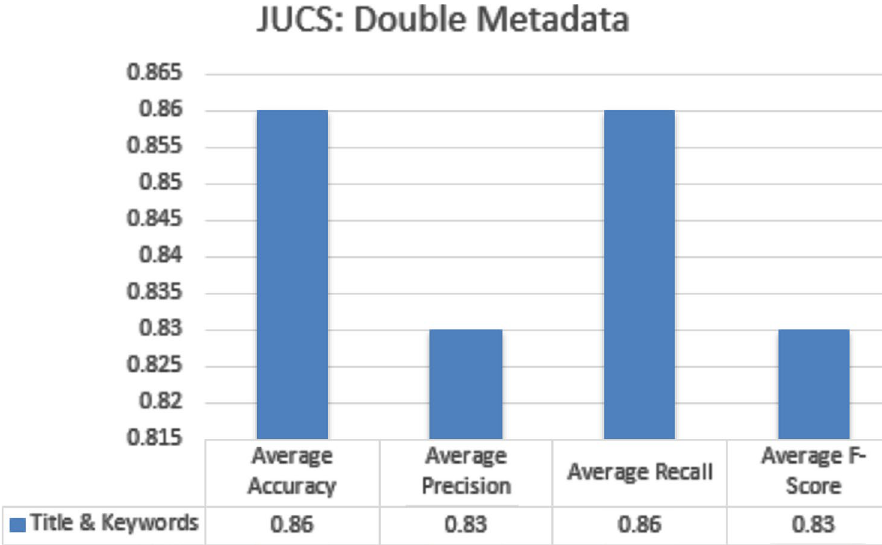
Figure 10. JUCS (double metadata).